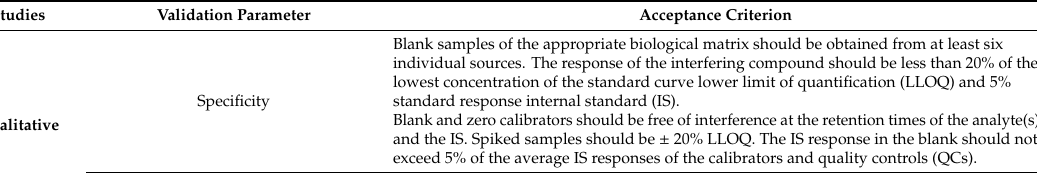
Table 1. Selected recommendations and acceptance criteria for the bioanalytical and analytical methods in accordance with the United States Food and Drug Administration (FDA), European Medicines Agency (EMA), and International Conference on Harmonization (ICH) guidelines [53–58]. Validation Parameter Acceptance Criterion